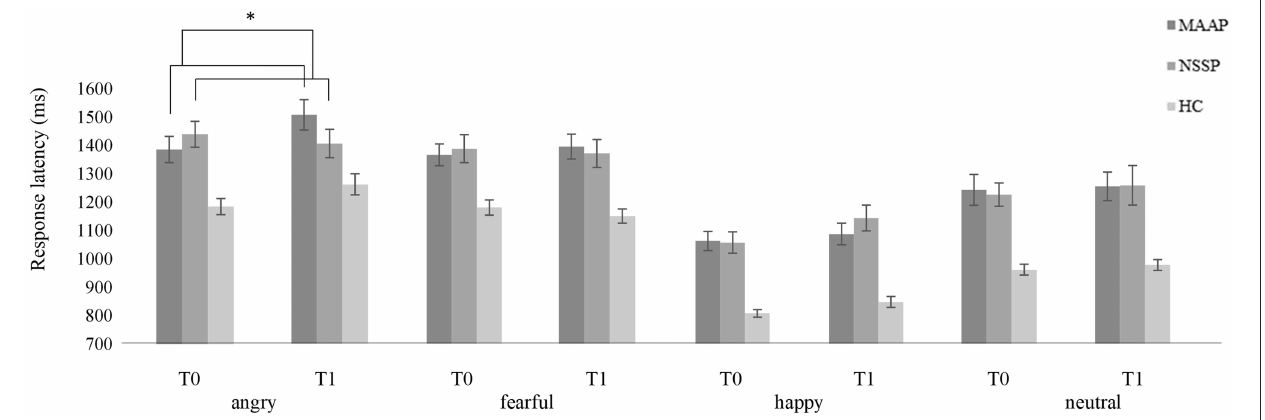
FIGURE 1 | Mean response latency ( ± one standard error) of patients with BPD in the MAAP group, in the NSSP group and healthy controls when classifying emotional facial expressions (angry, fearful, happy, or neutral) at pre-treatment (T0) and post-treatment measurements (T1). Please note that only time by treatment interaction is highlighted; refer to text for further significant effects. * p < 0.05.